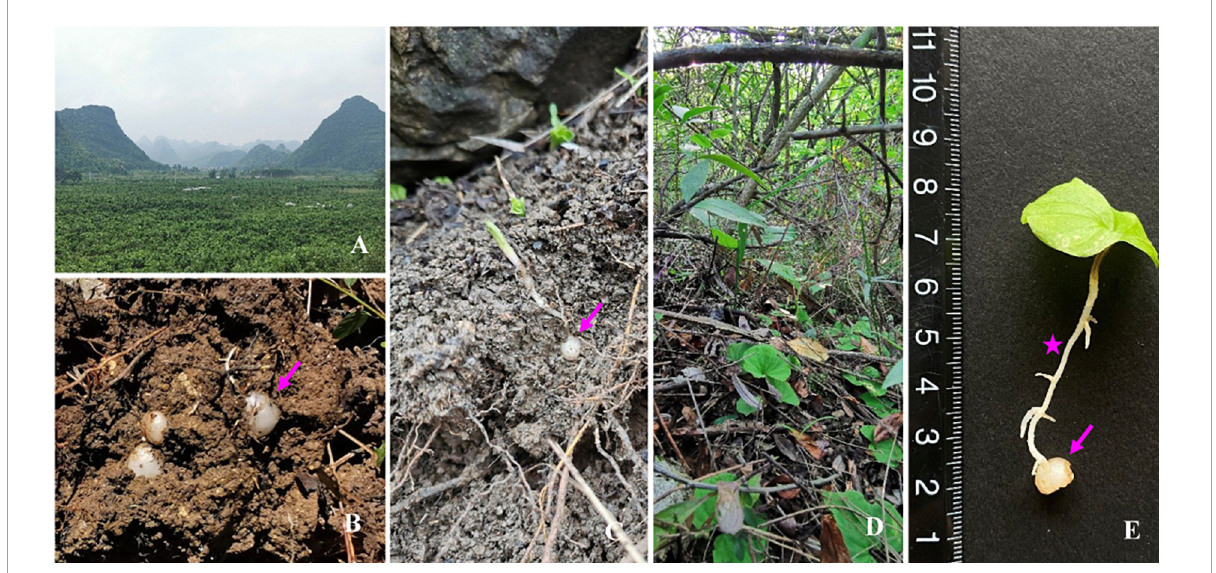
FIGURE1 Habitat of Nervilia fordii . (A) Nervilia fordii often located in the limestone mountains of the karst area in Guangxi Province, China. (B) The corm is the living state of N. fordii in every cold season. (C) The corm ( ↑ ) of N. fordii always sprout and break through the soil when the temperature rises in every March or April. (D) A community of N. fordii were found under bushes of the karst. (E) The whole plant of N. fordii is composed of the leaves, roots (*), and corms ( ↑ ).